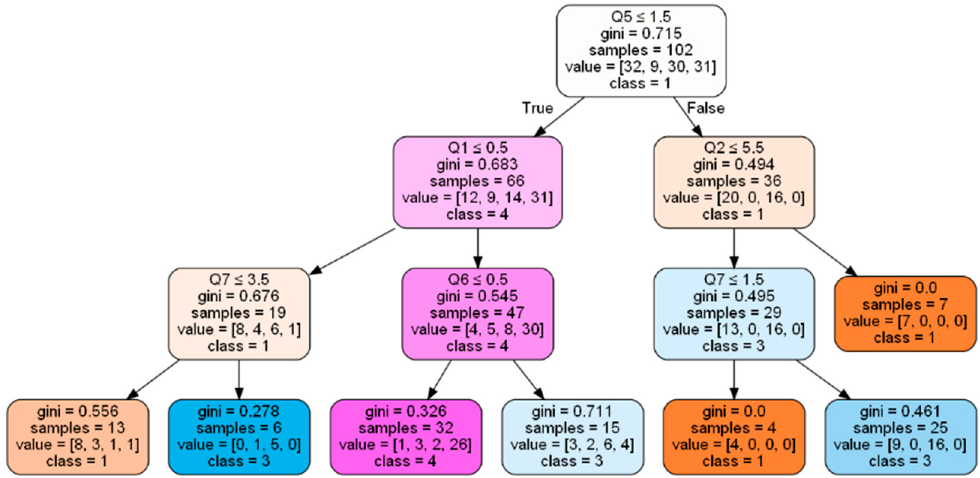
Table 6. Accuracy of the classification rate of the two criterion methods.